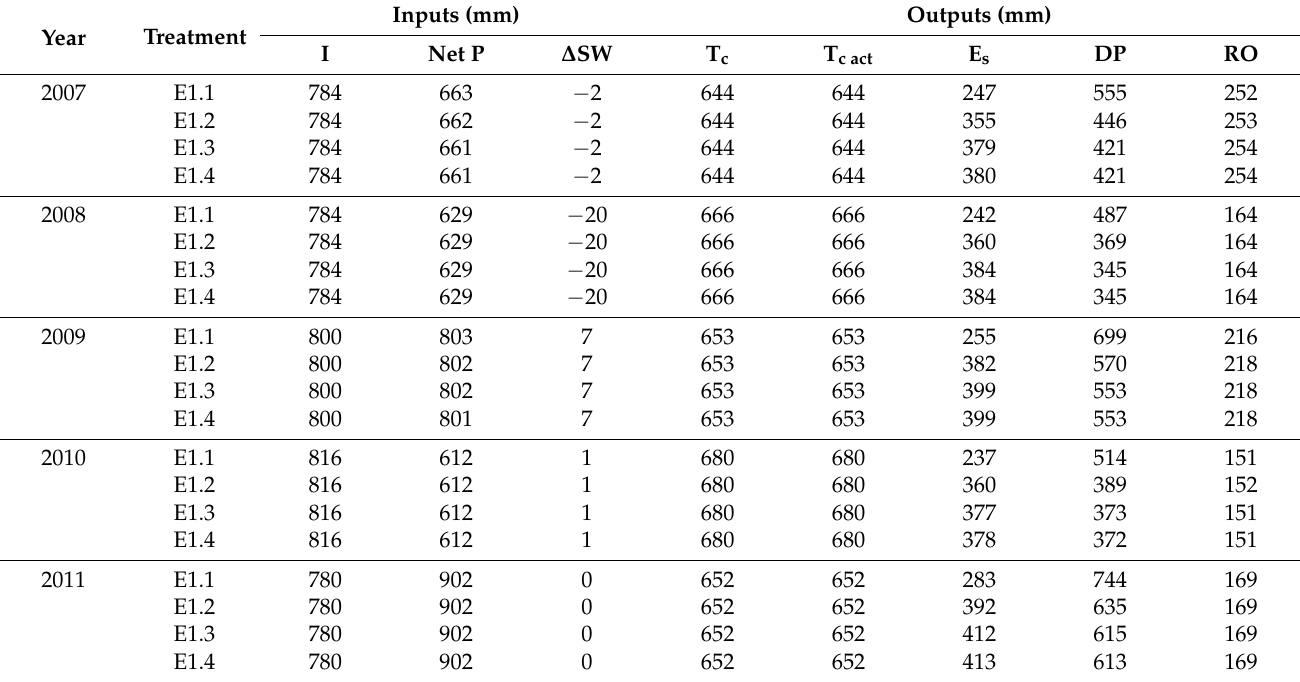
Table 11. Components of the annual water balance during E1 growing